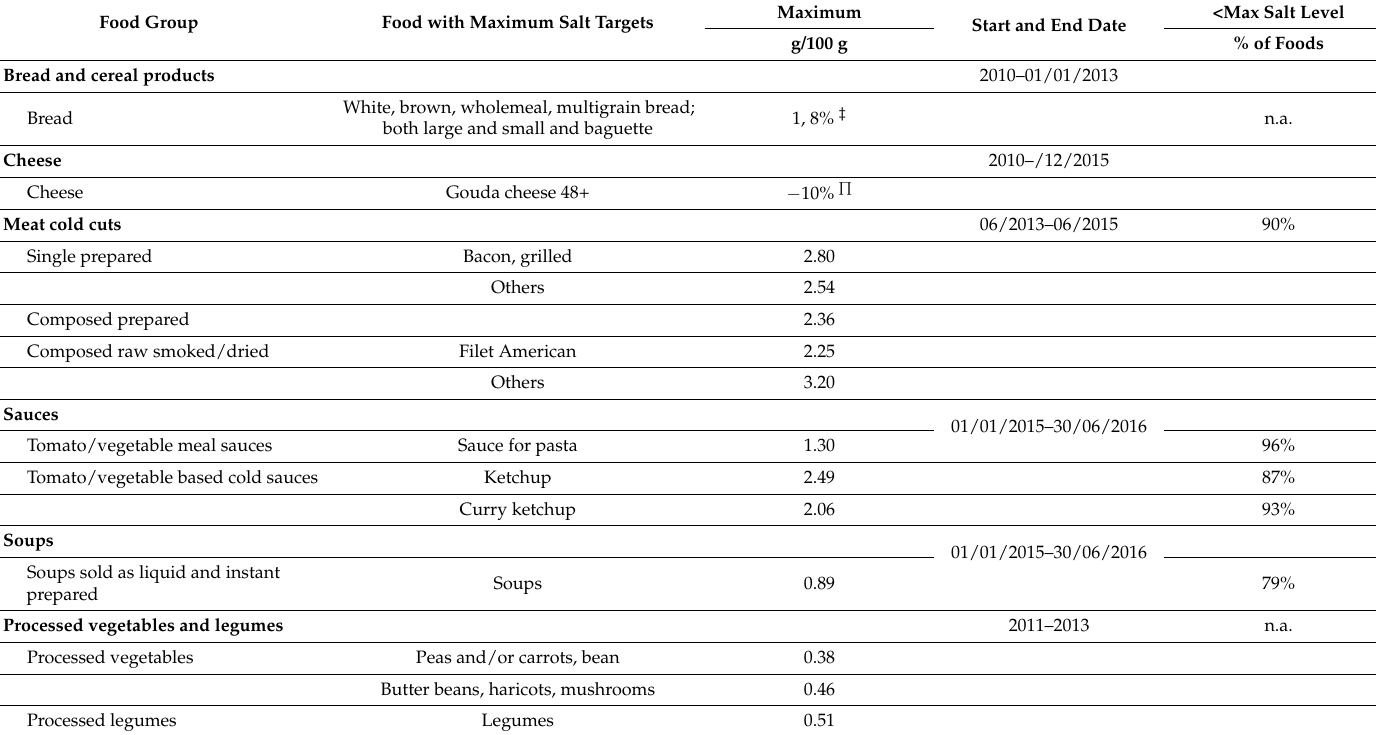
Table 2. Foods with maximum salt levels agreed on via Agreement on Improvement of Product Composition. Maximum <Max Salt Level Food Group Food with Maximum Salt Targets Start and End Date g/100 g % of Foods Bread and cereal products 2010–01/01/2013 White, brown, wholemeal, multigrain bread; Bread 1, 8% ‡ both large and small and baguette